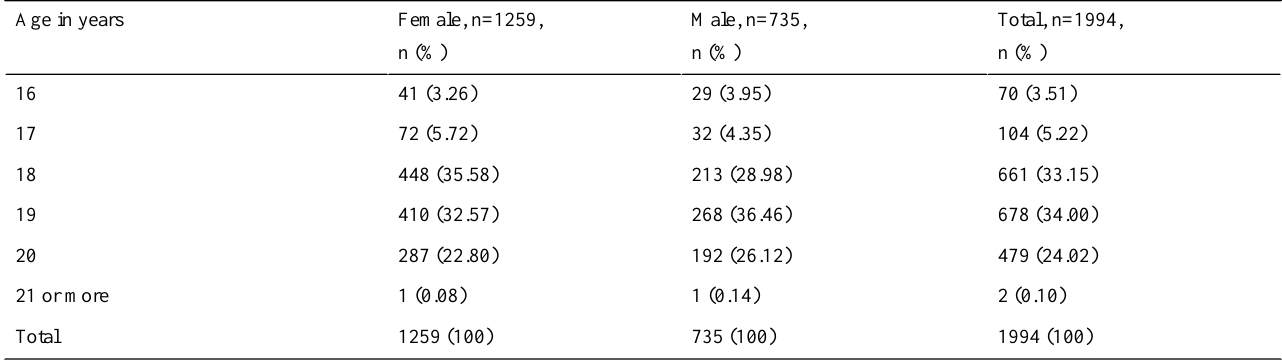
Table 1. Participant age at enrolment (by gender, male or female).